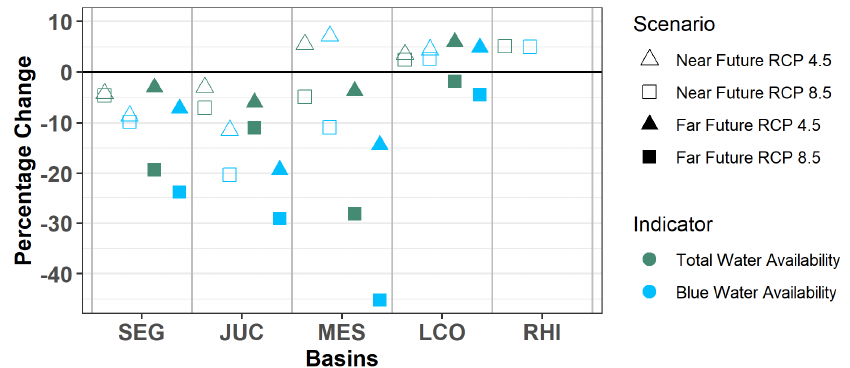
Figure 2. Percentage change of (1) total water availability ( green ) and (2) blue water availability ( blue ) for the five river basins for the climate change scenarios.